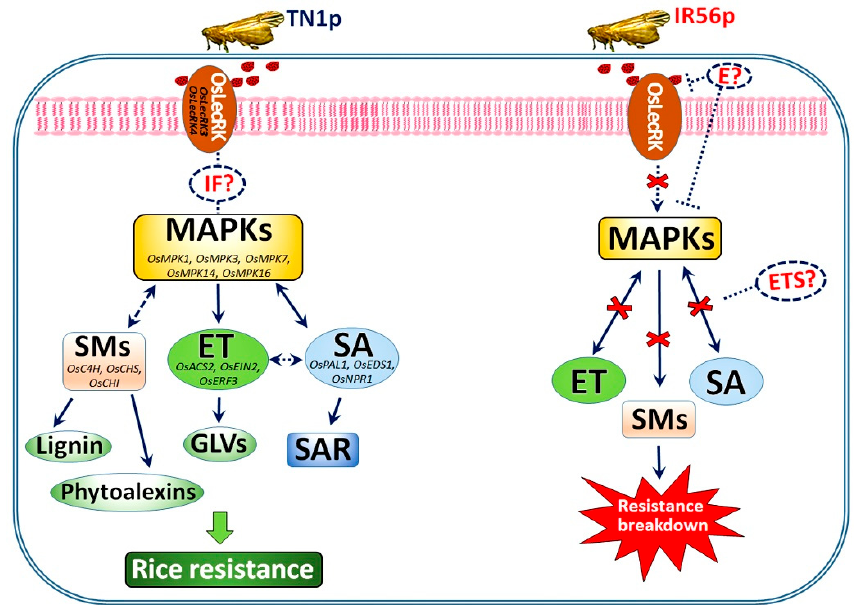
Figure 8. A conceptual model depicting the mechanism of the IR56 rice variety’s resistance against TN1-BPH and the breakdown of resistance in the IR56 rice variety by IR56-BPH. E: effectors; SM: secondary metabolites; ET: ethylene; SA: salicylic acid; ETS: effector-triggered susceptibility; IF: intermediate factors; GLV: green leaf volatiles; SAR: systemic acquired resistance. The solid lines indicate established regulatory connections, while the dashed lines represent a possible connection between different genes and factors.